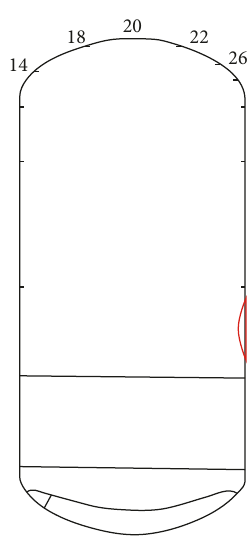
Figure 3: Zone vertical locations in PANDA ST1